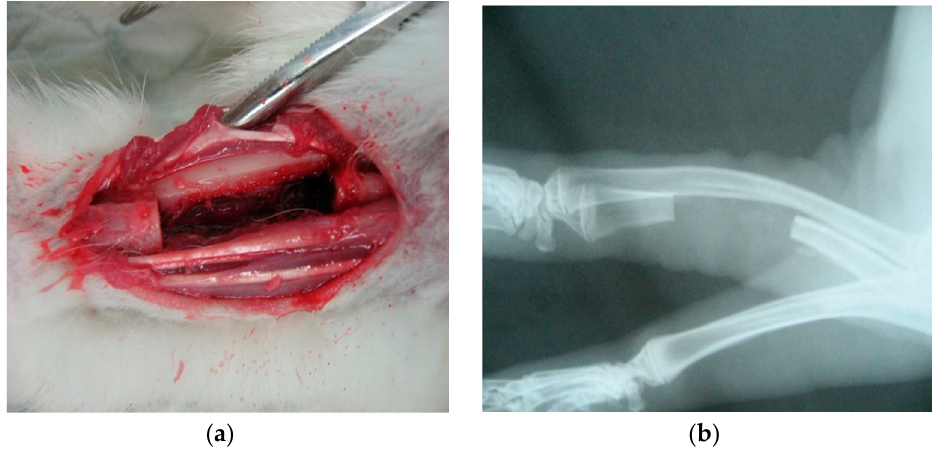
Figure 1. Critical-sized bone defect created on ulna of NZW rabbits. ( a ) Surgical sight; ( b ) Under X-ray imaging.